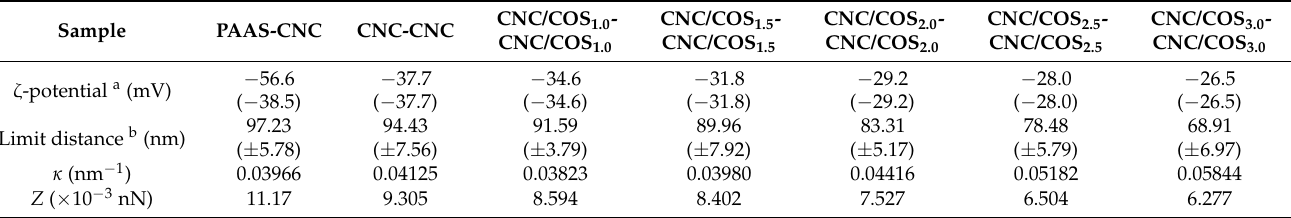
Table 1. ζ -potential, limit distance, κ , and Z of